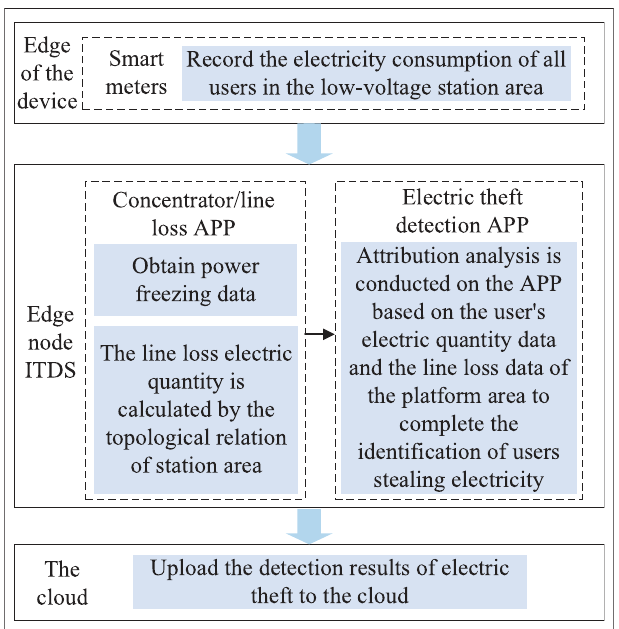
FIGURE 4 | Electricity theft detection framework with edge